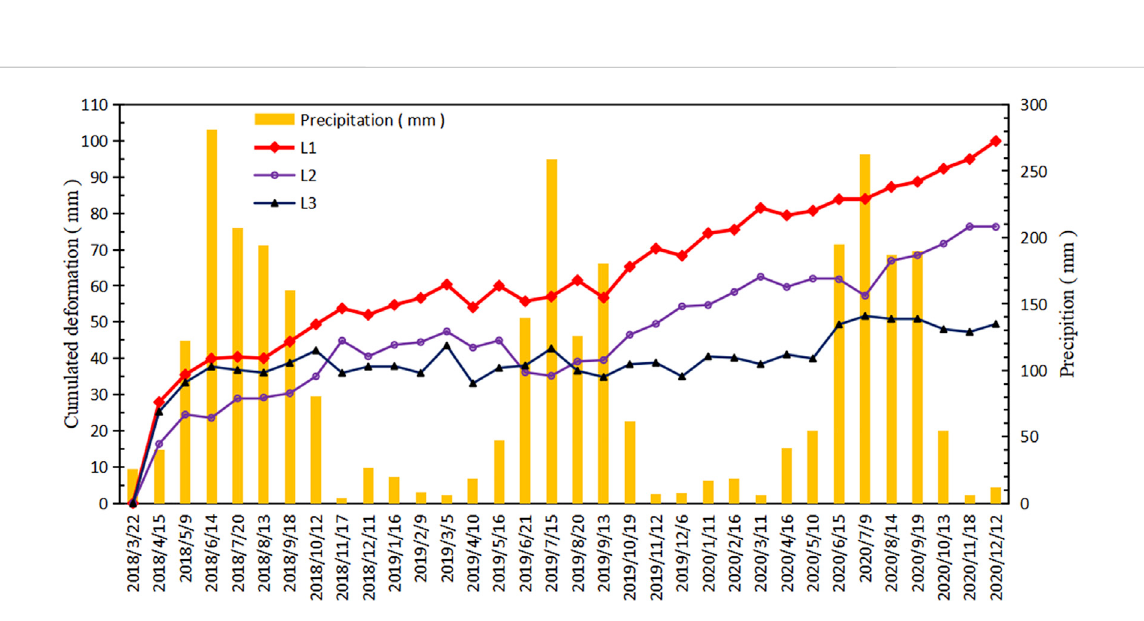
FIGURE 8 Time series deformation of feature points and precipitation in the left